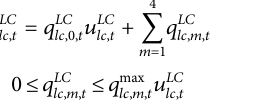
FIGURE 4 Schematic of load